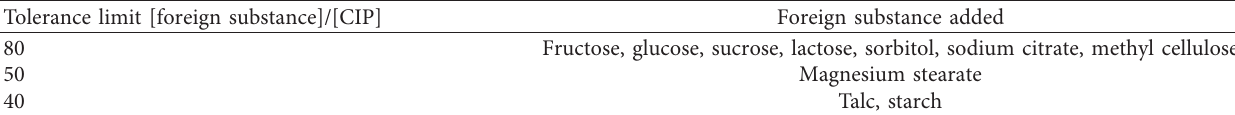
Table 3: Effect of some foreign interference compounds.